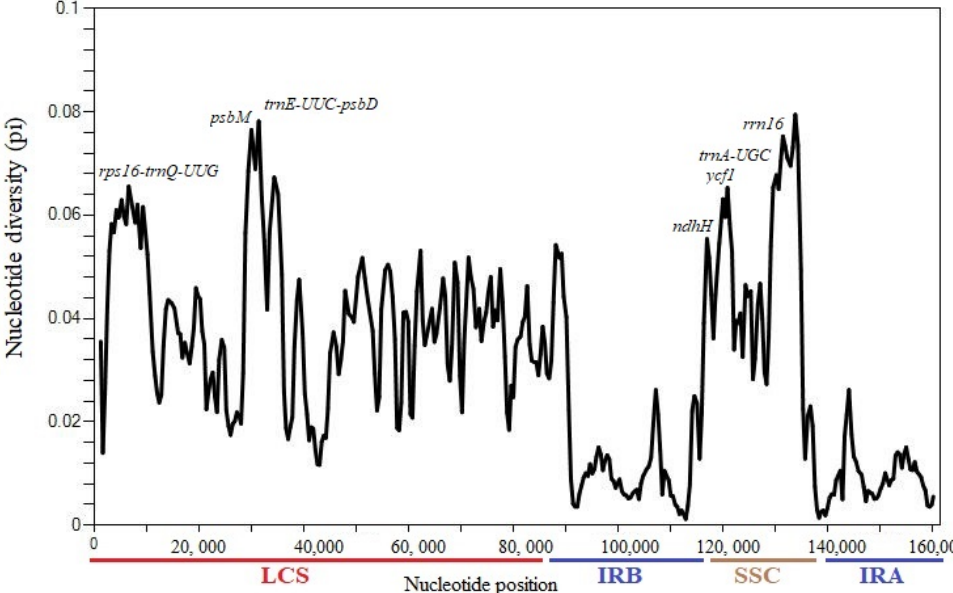
Figure 8. Sliding window analysis of nucleotide variability among the seven Justiceae species cp genomes (windowlength: 600 bp; step size: 200 bp).